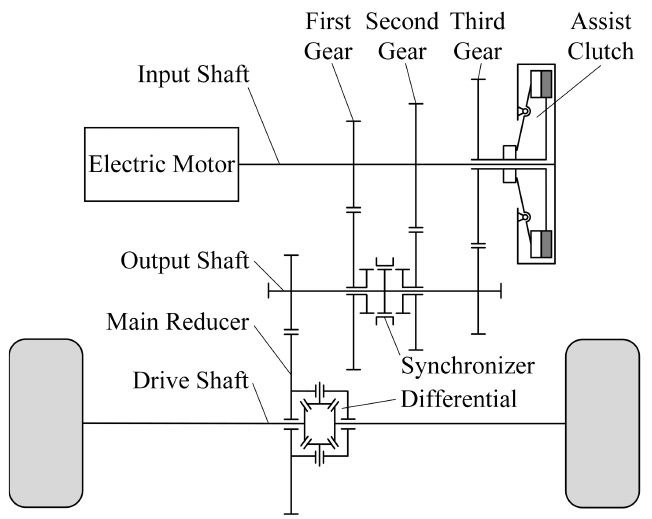
Figure 1. Schematic diagram of the drive system.